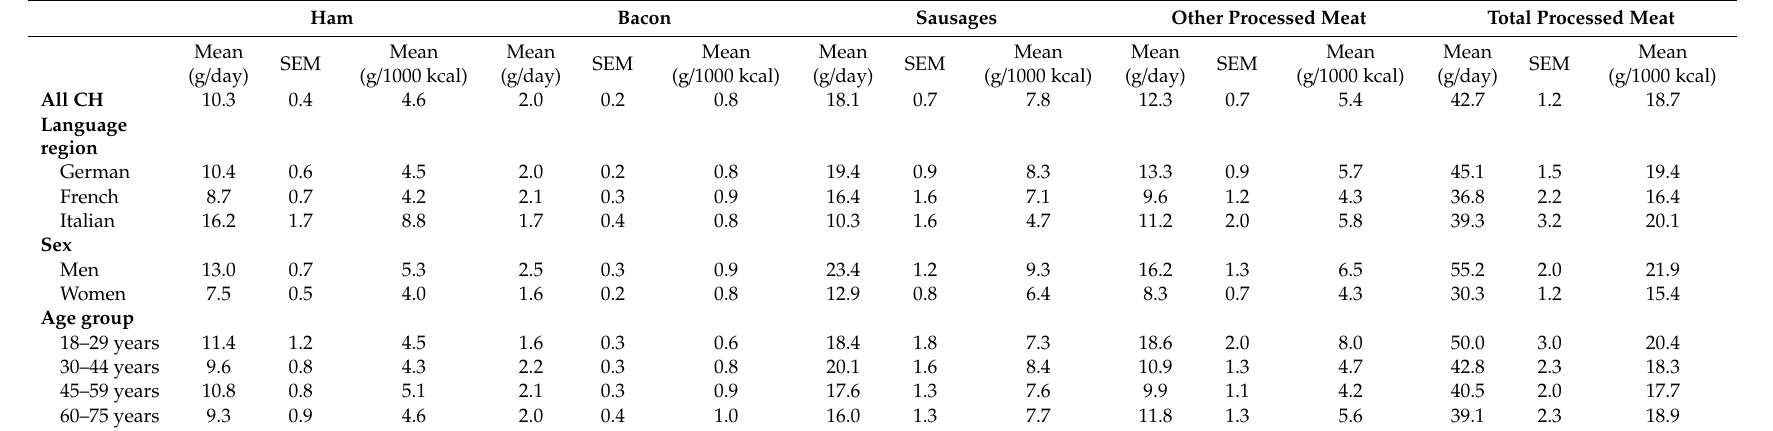
Table 2. Mean daily intake for total and main categories of processed meats for the population (all CH) and by language region, sex, and age group (g / day; g / 1000 kcal). Ham Bacon Sausages Other Processed Meat Total Processed Meat